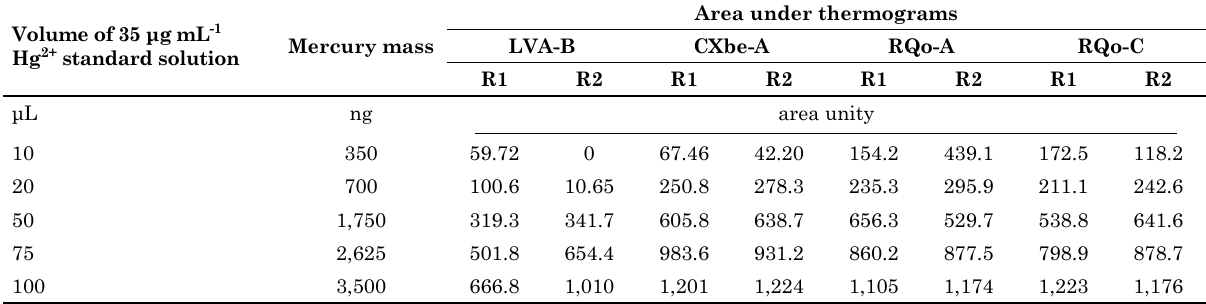
table 3. area under thermograms at each point of calibration curves in four soil samples (typic haplustox - lva, oxic eutric haplustept - cXbe, and Quartzipsamment - rQo Volume of 35 μg mL